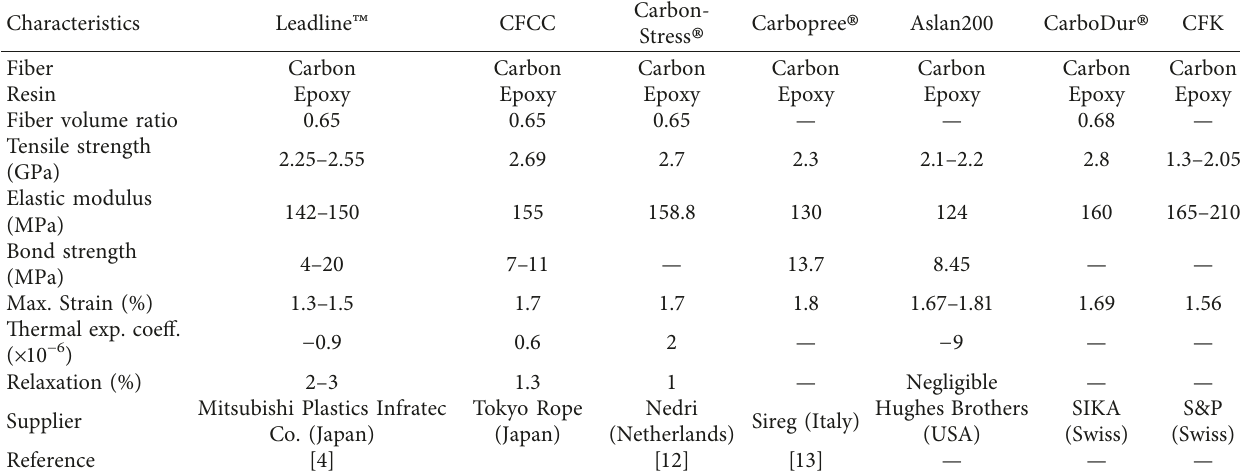
Table 2: Commercialized CFRP tendons.